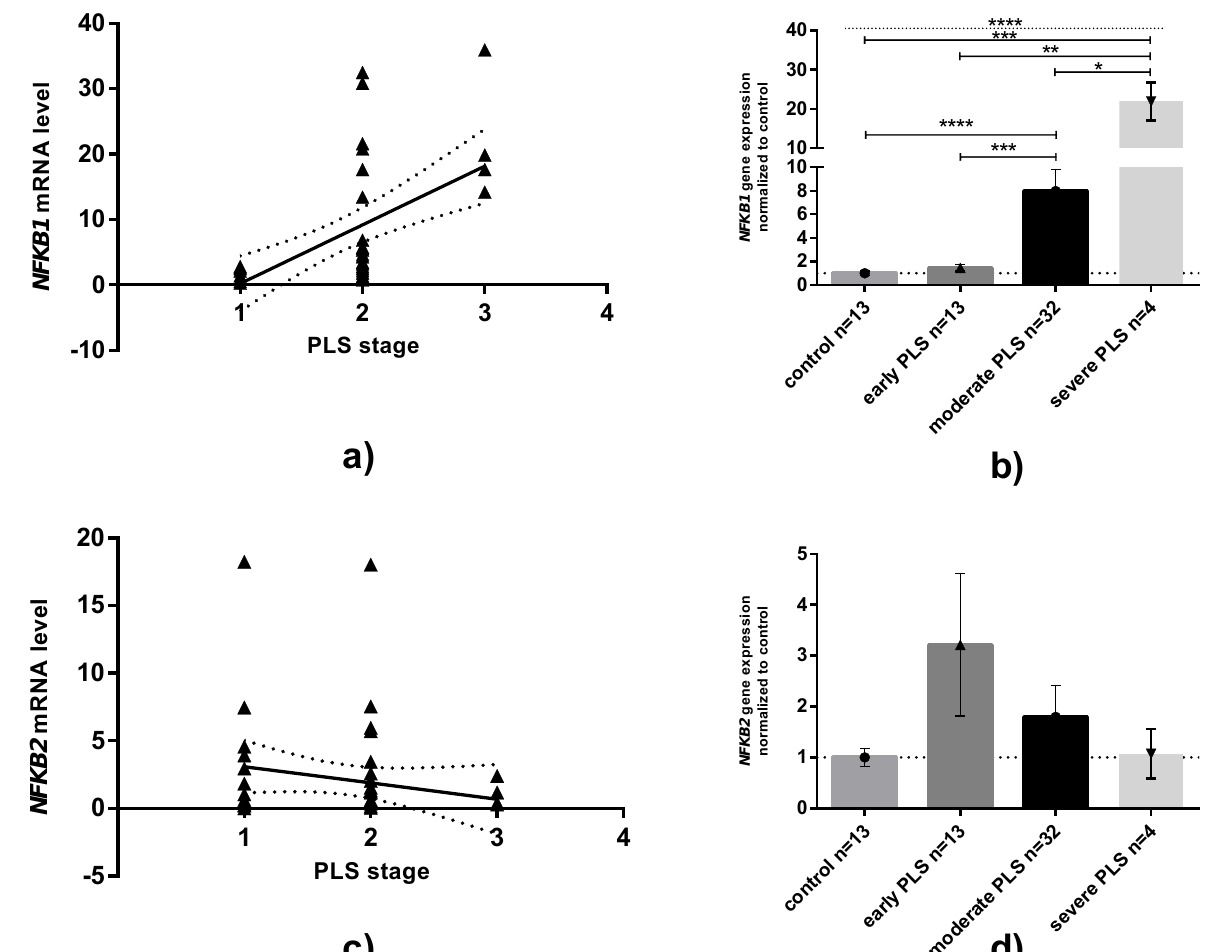
Figure 2. Expression of NFKB1 and NFKB2 mRNA in penile lichen sclerosus classified in relation to the severity of disease. ( a , c ): correlation plots between either NFKB1 or NFKB2 and PLS stages. Solid line: linear regression with 95% confidence interval. ( b , d ): NFKB1 or NFKB2 mRNA expression levels divided by disease stages: Bars and whiskers represent the mean ± SD normalized to control foreskin samples (presented as 1). * p < 0.05, ** p < 0.01, *** p < 0.001, **** p < 0.0001 (Mann–Whitney U test between each group, solid line; Kruskal–Wallis ANOVA test between all groups, dotted line). Abbreviation: PLS, penile lichen sclerosus.